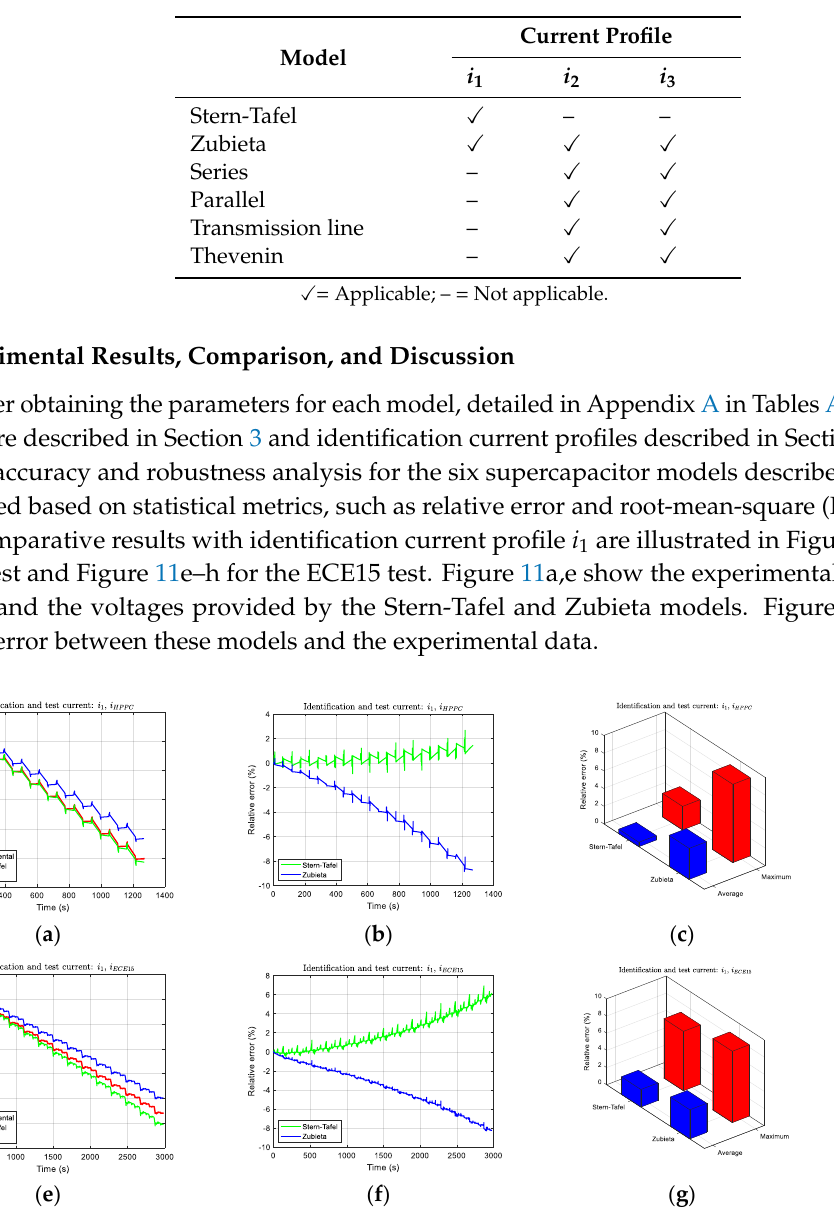
Figure 11. Experimental data and supercapacitor models time response, relative error (%), RMS error (mV): ( a ) – ( d ) current profile HPPC for i 1 , ( e ) – ( h ) current profile ECE15 for i 1 .